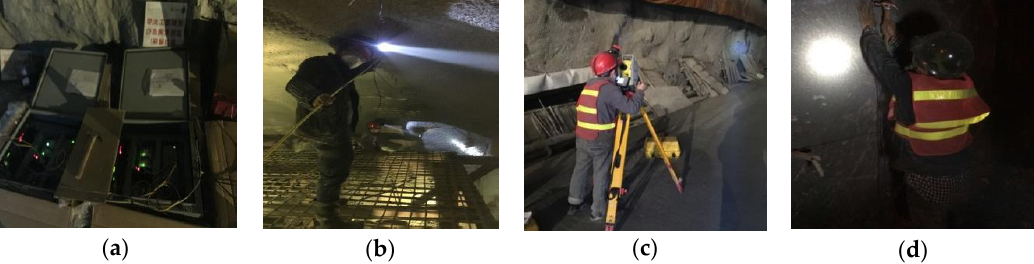
Figure 8. Artificial knock test: ( a ) and ( b ) establishment of microseismic system and installation of sensor arrays; ( c ) coordinates of knock test point measured by total station; ( d ) hammer is used to hit the test point to excite artificial waves.